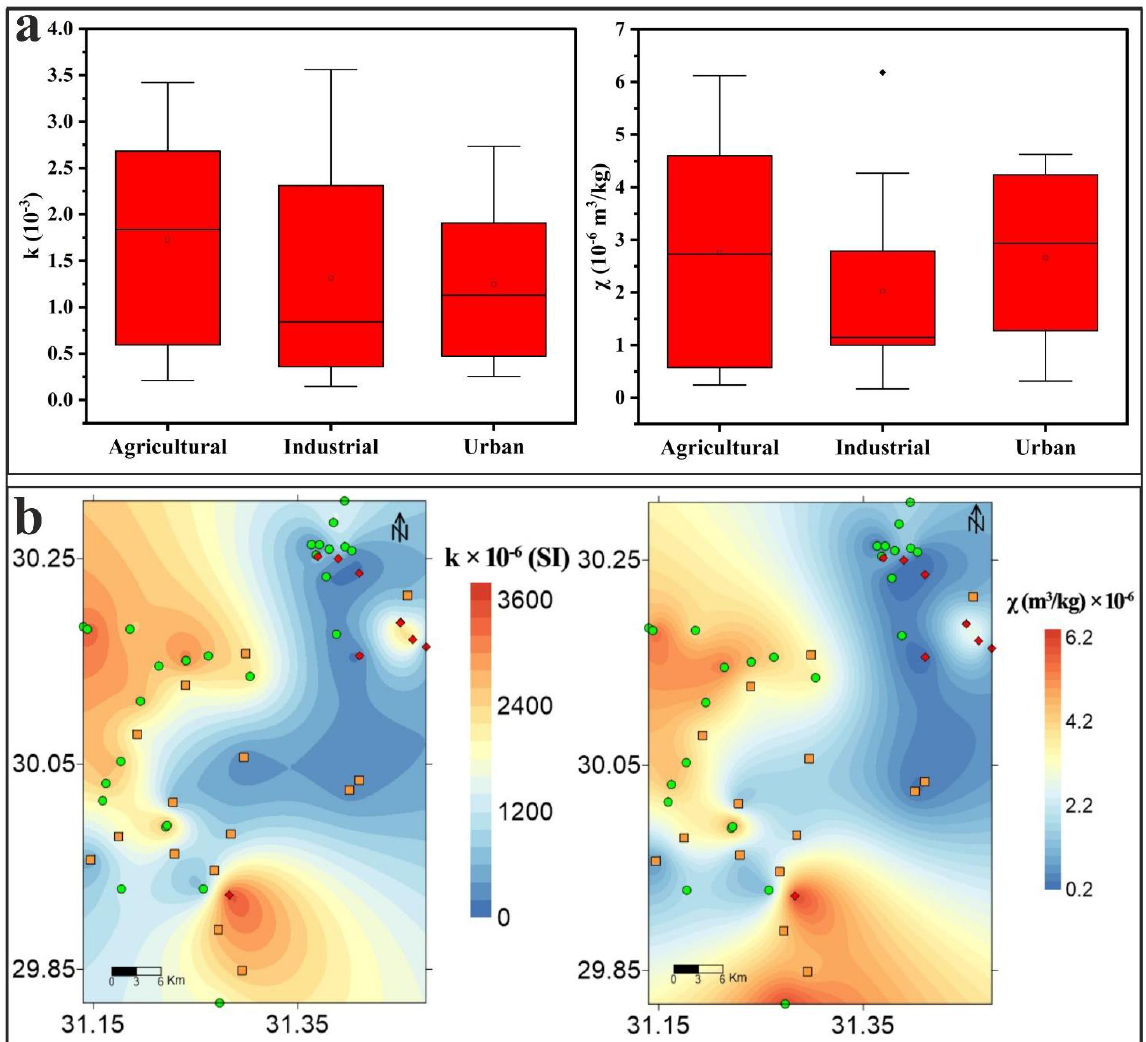
Figure 8. Boxplots of k and χ values ( a ); Spatial distribution of k and χ values ( b ).